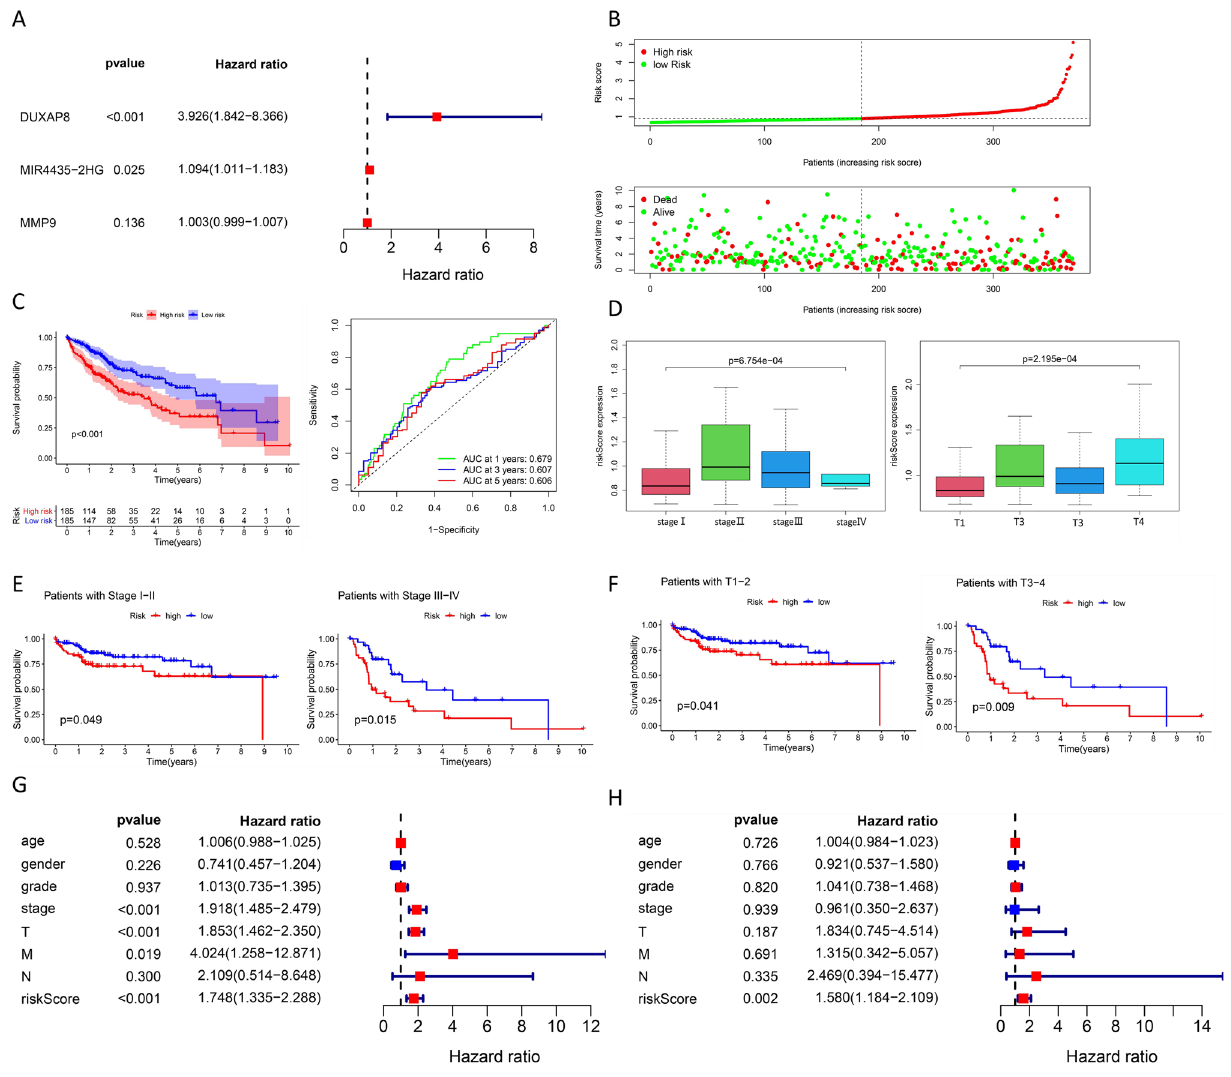
Fig. 5 Construction of risk models for MIR4435-2HG and DUXAP8. a Multifactorial Cox regression analysis of MIR4435-2HG, MMP9, and DUXAP8. b Classification of HCC patients into two groups (high-risk and low-risk groups) according to the median risk scores. c Classification of liver cancer patients into high-risk and low-risk groups according to the median risk scores. d Correlation of TNM stage and depth of inva- sion (T) with risk scores. e Survival curves for the stage I–II (n = 163) and stage III–IV (n = 72) groups. f Survival curves for the T1–2 (n = 167) and T3–4 (n = 68) groups. g Univariate Cox and h multivariate Cox regression